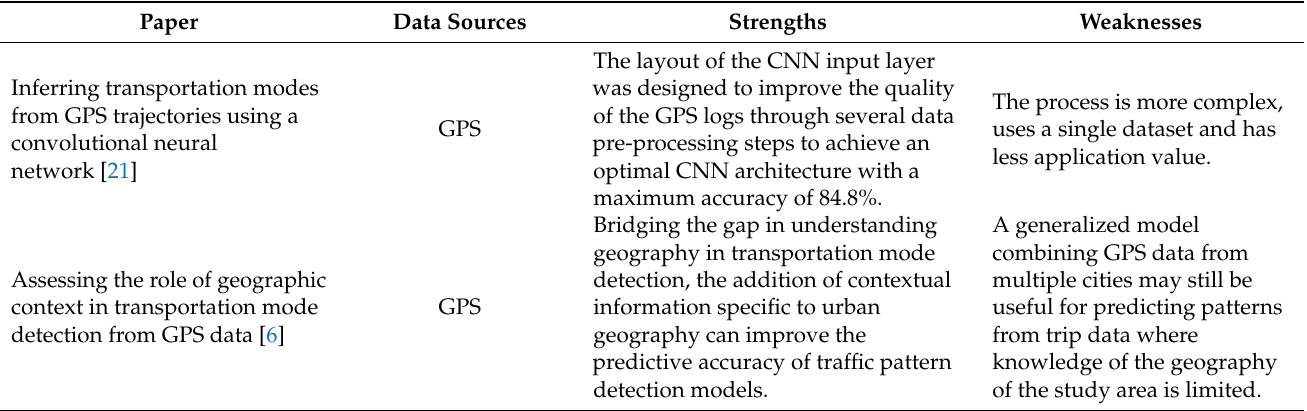
Table 1. Advantages and disadvantages of related